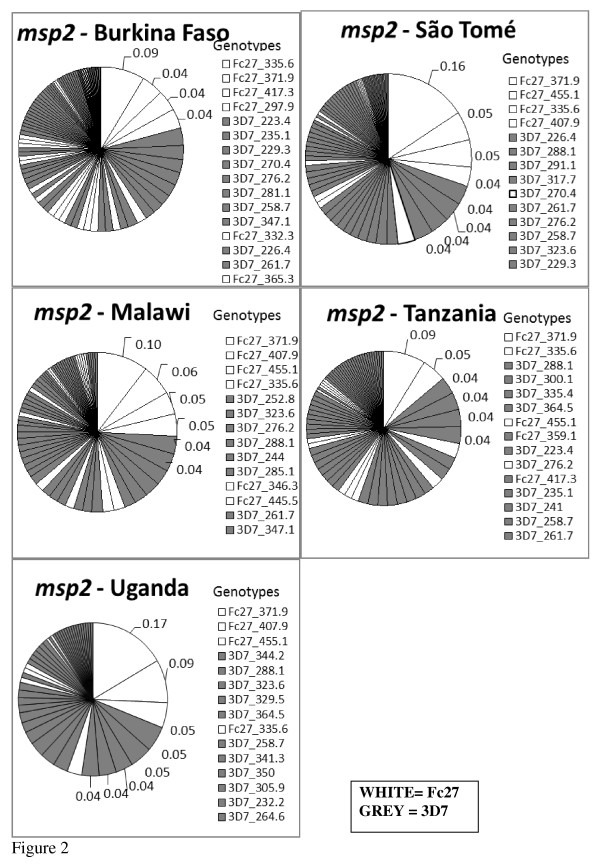
msp2 allelic diversity and frequency (%) by country. Only three genotypes, all from FC27 family occurred at of above 5%. Note; only genotypes with frequency ≥ 4% (0.04) are labeled.